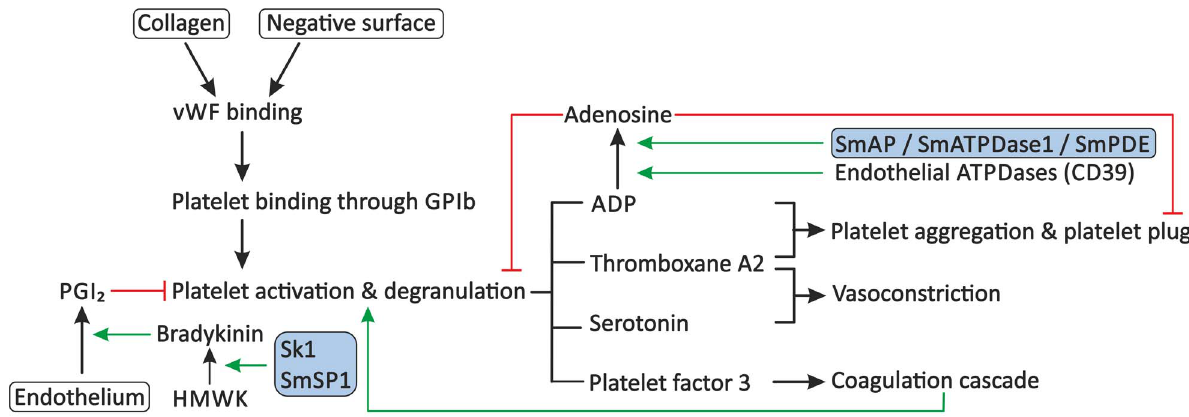
Figure 2. Proposed modulation of primary haemostasis by schistosomes. Primary haemostasis consists of the activation of blood platelets and the formation of a platelet plug. Exposure of subendothelial collagen, due to endothelial damage or the presence of soluble activators or surfaces of pathogens, can facilitate binding of VWF. Platelets adhere to VWF through GPIb present on their surface, followed by their activation and degranulation. Platelets release molecules, such as ADP, thromboxane A2, serotonin, and platelet factor 3, which stimulate further platelet aggregation and activation, stimulate vasoconstriction, and activate secondary haemostasis. Primary haemostasis is inhibited by PGI 2 from endothelial cells, which inhibits degranulation of platelets, and by the degradation of extracellular ADP to AMP and subsequently to the inhibitor adenosine by endothelial ATPDases, such as CD39. Schistosomes interfere with the primary haemostasis through the proposed degradation of extracellular ADP by SmAP, SmATPDase1, and/or SmPDE, and potentially stimulate the release of PGI 2 through up-regulation of the production of bradykinin by sK1 or SmSP1. Stimulation is indicated by green arrows. Red lines indicate inhibition. Schistosome proteins are indicated in the shaded boxes. Abbreviations: glycoprotein Ib (GPIb), High-molecular-weight kininogen (HMWK), prostacyclin (PGI 2 ), Schistosoma mansoni alkaline phosphatase (SmAP), Schistosoma mansoni ATP-diphosphohydrolase-1 (SmATPDase1), Schistosoma mansoni phosphodiesterase (SmPDE), von Willebrand Factor